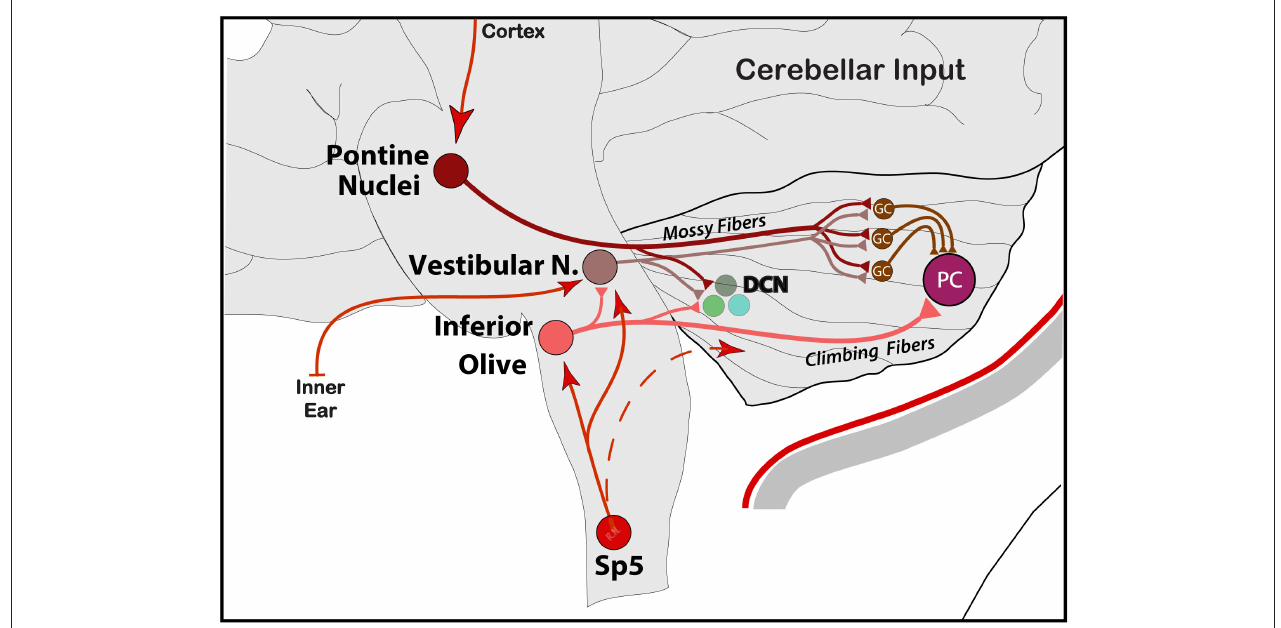
FIGURE 3 | Schematic representation of the main input entering the cerebellum from PN via cortico-ponto-cerebellar, IO via spino-olivo-cerebellar and vestibular signals from the inner ear into VN and the rest of the vestibulo-cerebellar central system. Note the collaterals to deep cerebellar nuclei (DCN). Input from the hypothalamus is not shown. GC, granule cells; PC, Purkinje